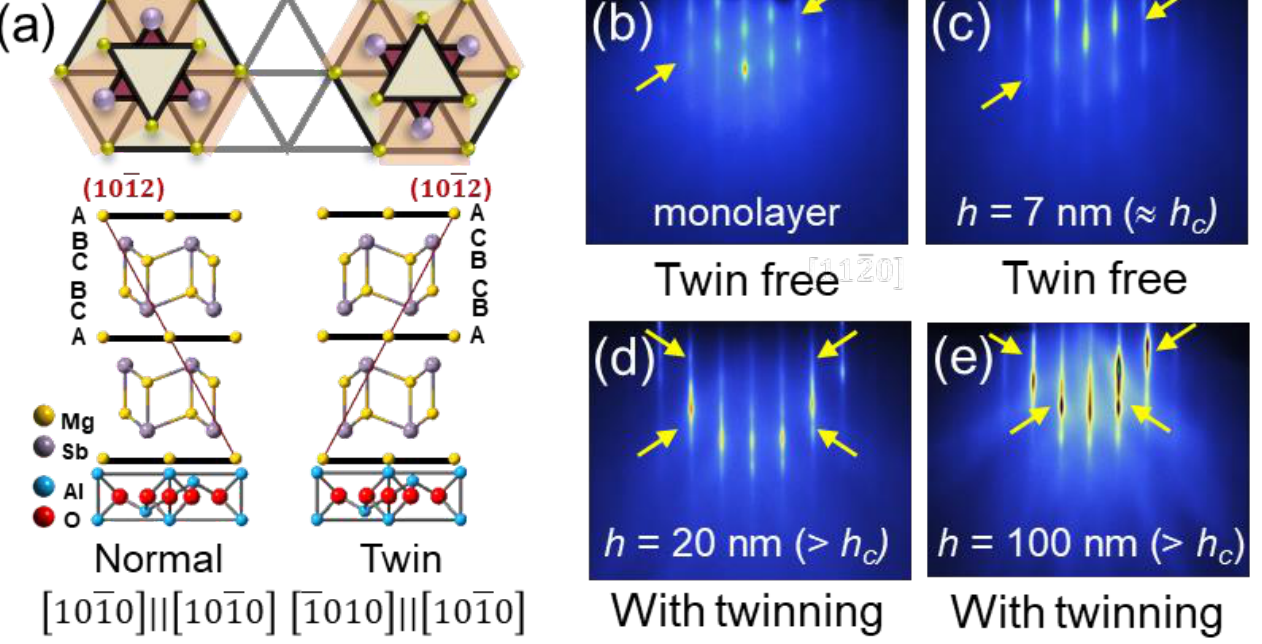
Figure 4. ( a ) Schematic stacking order of the twin structure in Mg 3 Sb 2 . Top and middle panels: two representative stacking orders in Mg 3 Sb 2 , where the 3-fold symmetry is visible in the top view. Bottom: the interlayer stacking follows a relation of [1010]//[101 0] for the normal domain (left), while the stacking relation of [1 010]//[101 0] represents the twin domain (right). The {1012} planes (in red) and the atomic stacking sequence (ABC-BCA and ACB-CBA) are drawn as references. ( b – e ) RHEED patterns measured during the deposition of the Mg 3 Sb 2 film that is grown at T sub = 773 K. The intensity modulation highlighted by arrows reveals the presence/absence of the twin structure. The mirror symmetric diffraction pattern indicates the existence of twin structure, while the diagonal feature depicts the absence of twin structure. ( b , c ) indicate the film with twin-free structure at the initial stage of deposition, whereas ( d , e ) indicate the twinning structure gradually forms when the film thickness during the further